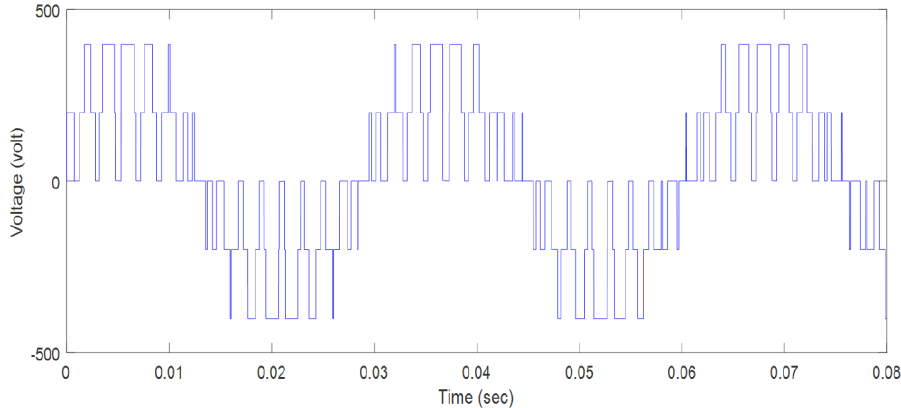
Figure 11. Simulation of a 2-leg, 5-level DC-MLI.